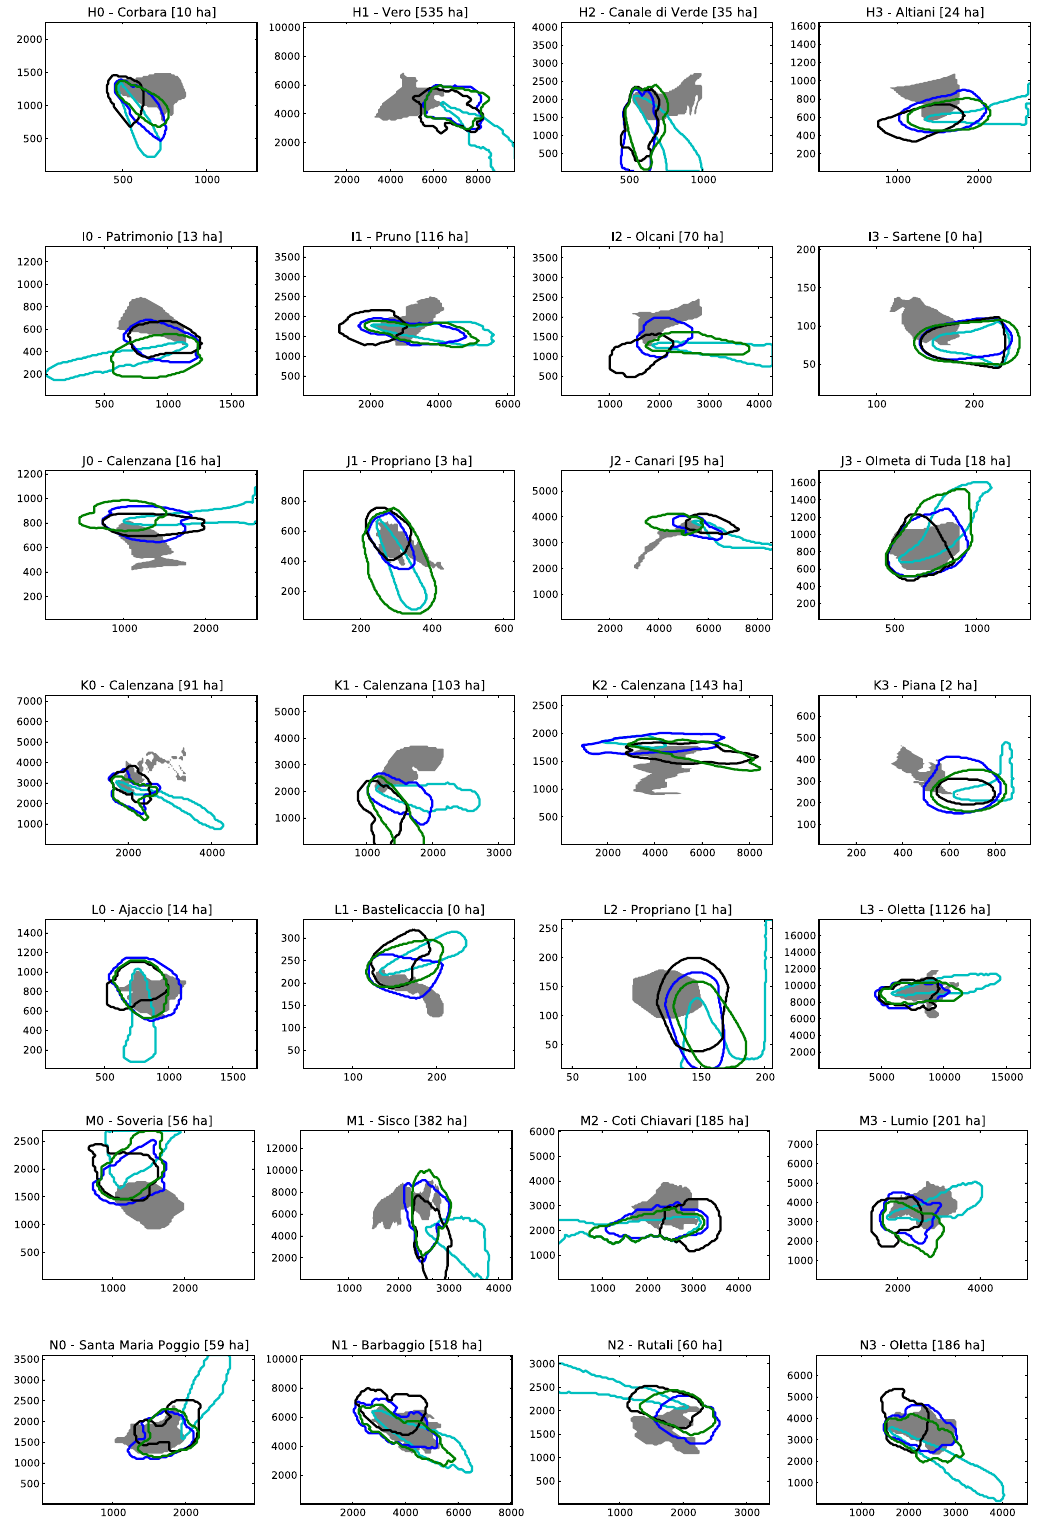
Figure A2. Simulation for all fires (2/3). The non-stationary Balbi model is in blue; the stationary Balbi model is in green; the Rothermel model is in black; the 3-percent model is in cyan. The gray area is the observed final burned area. The coordinates are meters.